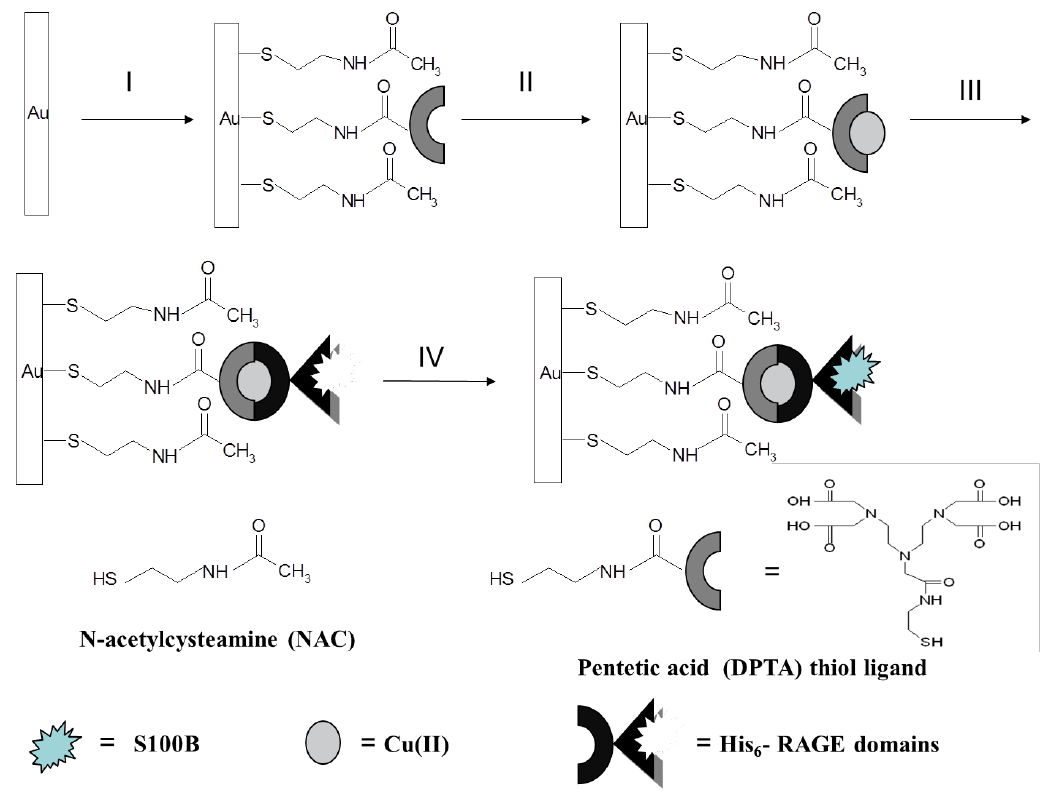
Figure 1. The scheme of the biosensor based on N -Acetylcysteamine/thiol derivative of pentetic acid (NAC/DPTA)–Cu(II) self-assembled monolayer (SAM).